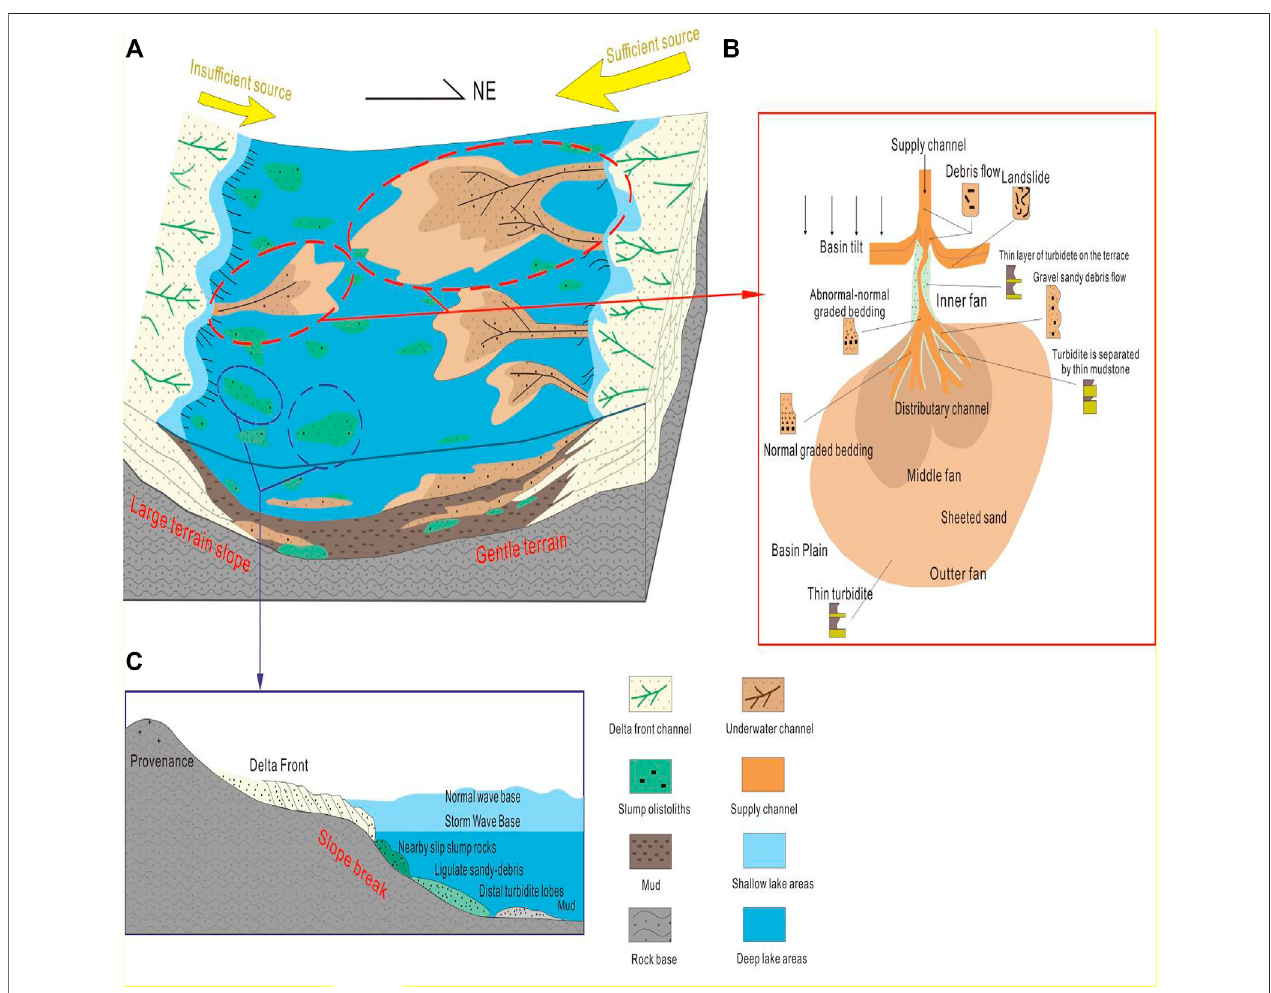
FIGURE 11 | Gravity- fl ow depositional model of Chang 6 in Heshui area. (A) Gravity depositional system in the study area; (B) depositional model of slump olistoliths; (C) depositional model of sublacustrine fans.